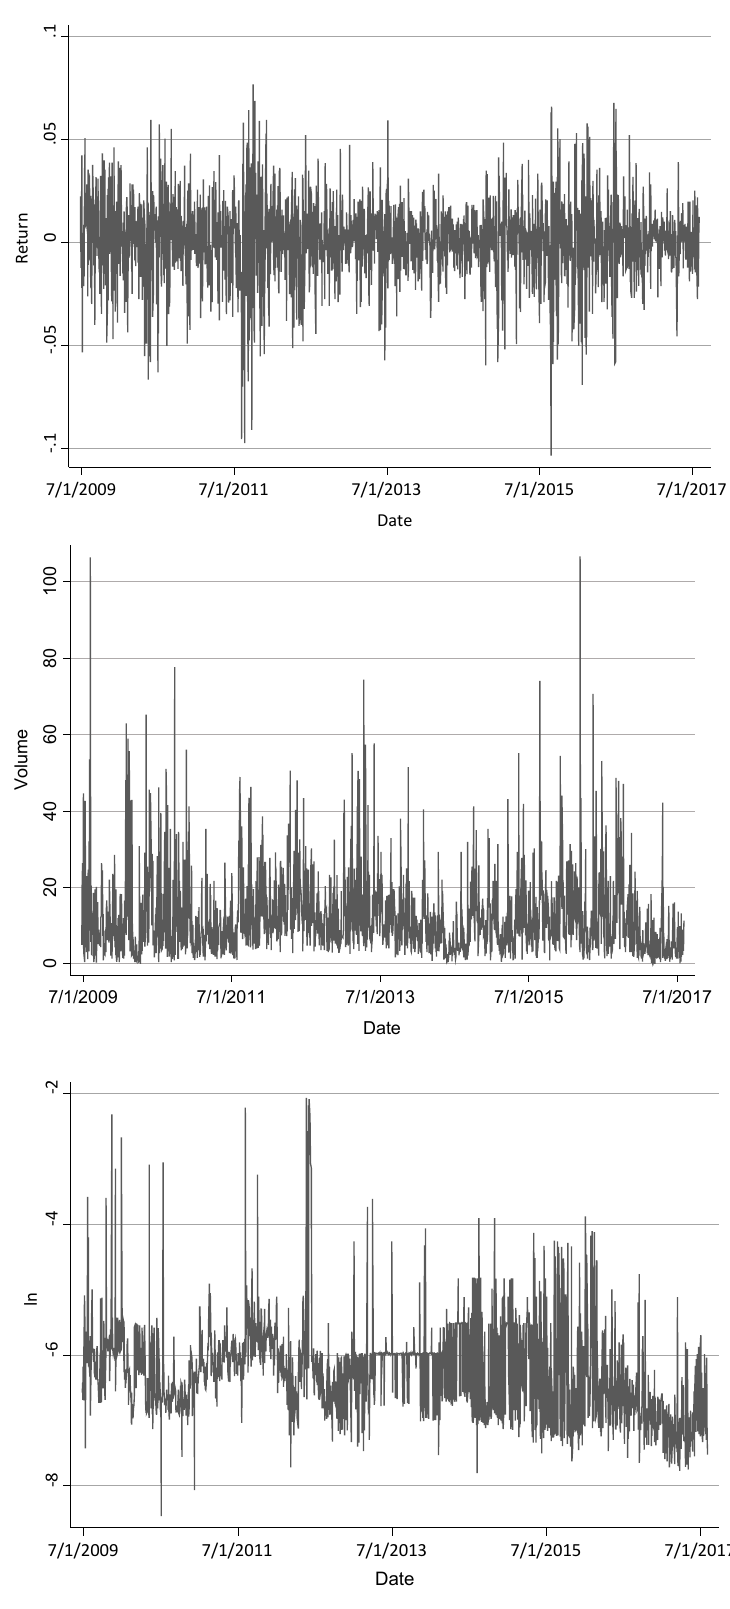
Figure 3. Time series plots of volume, natural logarithm of spread and